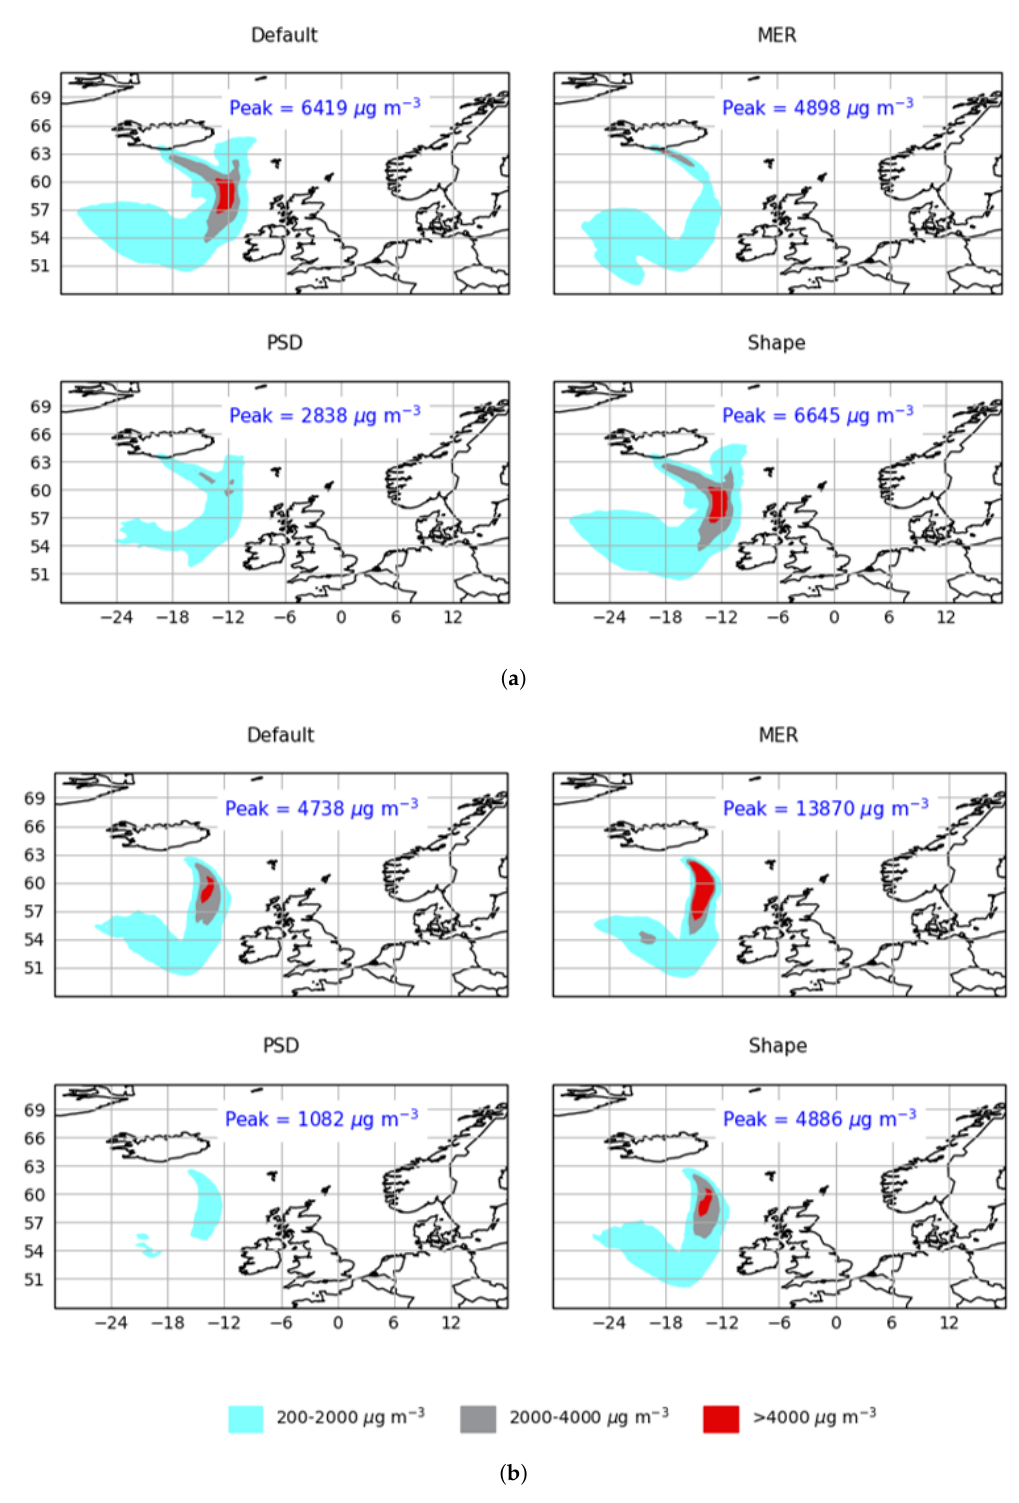
Figure 5. Assessment of dispersion model sensitivity to ESPs, showing six-hour averaged predicted ash concentration in the Eyjafjallajökull ash cloud at 06:00 UTC on the 7th May 2010 at ( a ) FL00-200 and ( b ) FL200-350. The four maps show simulations initialised with: the VAAC Default ESPs, a MER and vertical distribution determined from the Buoyant Plume model, the VAAC’s Coarse PSD, and Extreme Particle Shape